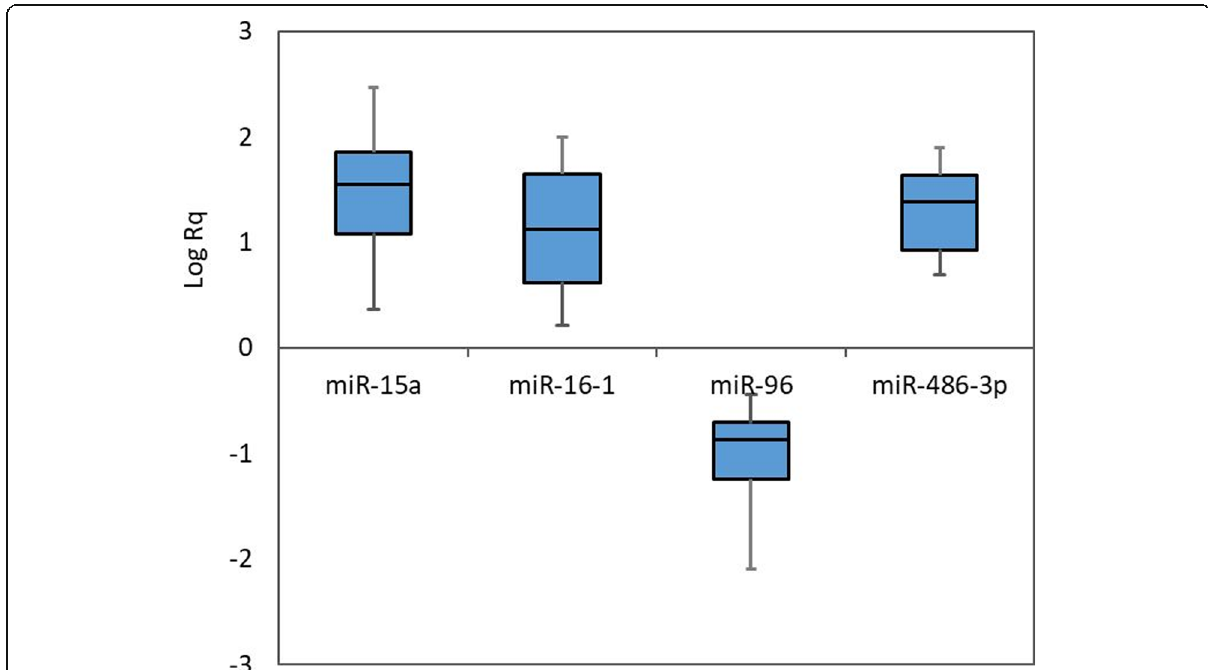
Fig. 1 Box and whisker plots representing the expression of the 4 miRNAs in the studied groups (the plot shows the maximum and minimum values, the median, Q1, Q3, and the interquartile range)